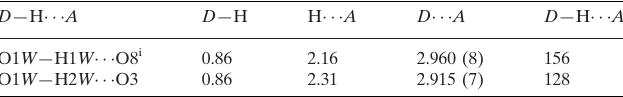
Hydrogen-bond geometry (A˚ , (cid:3)